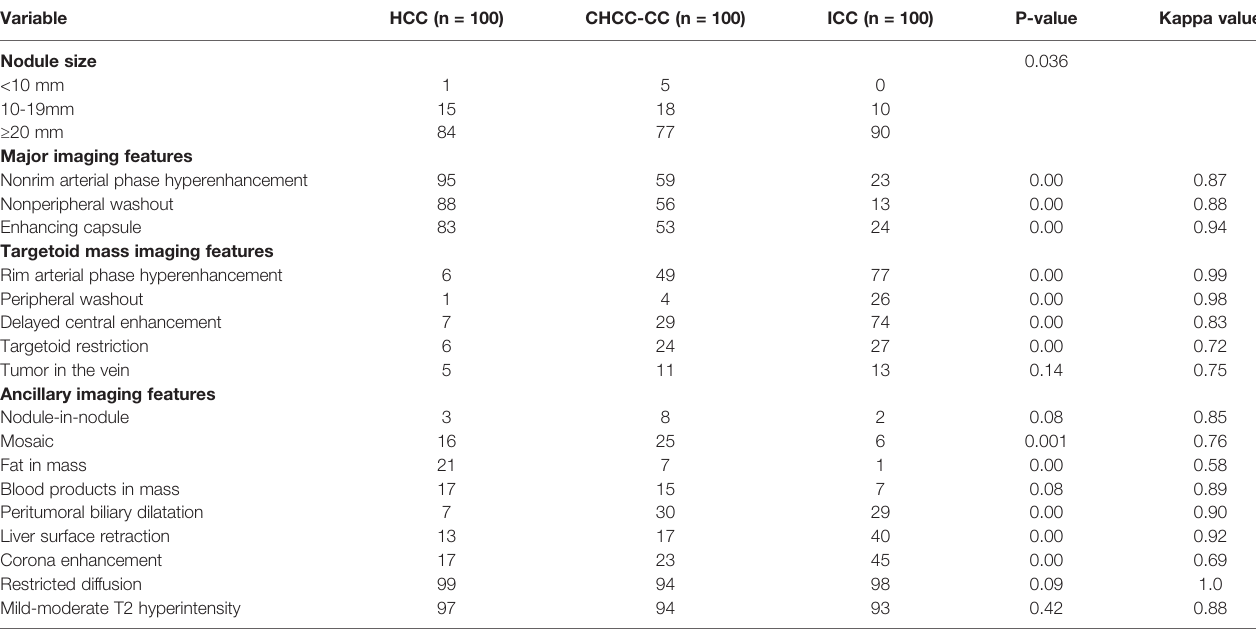
TABLE 2 | Imaging characteristics of hepatic tumors in cirrhotic liver at gadopentetate acid-enhanced MRI. Variable